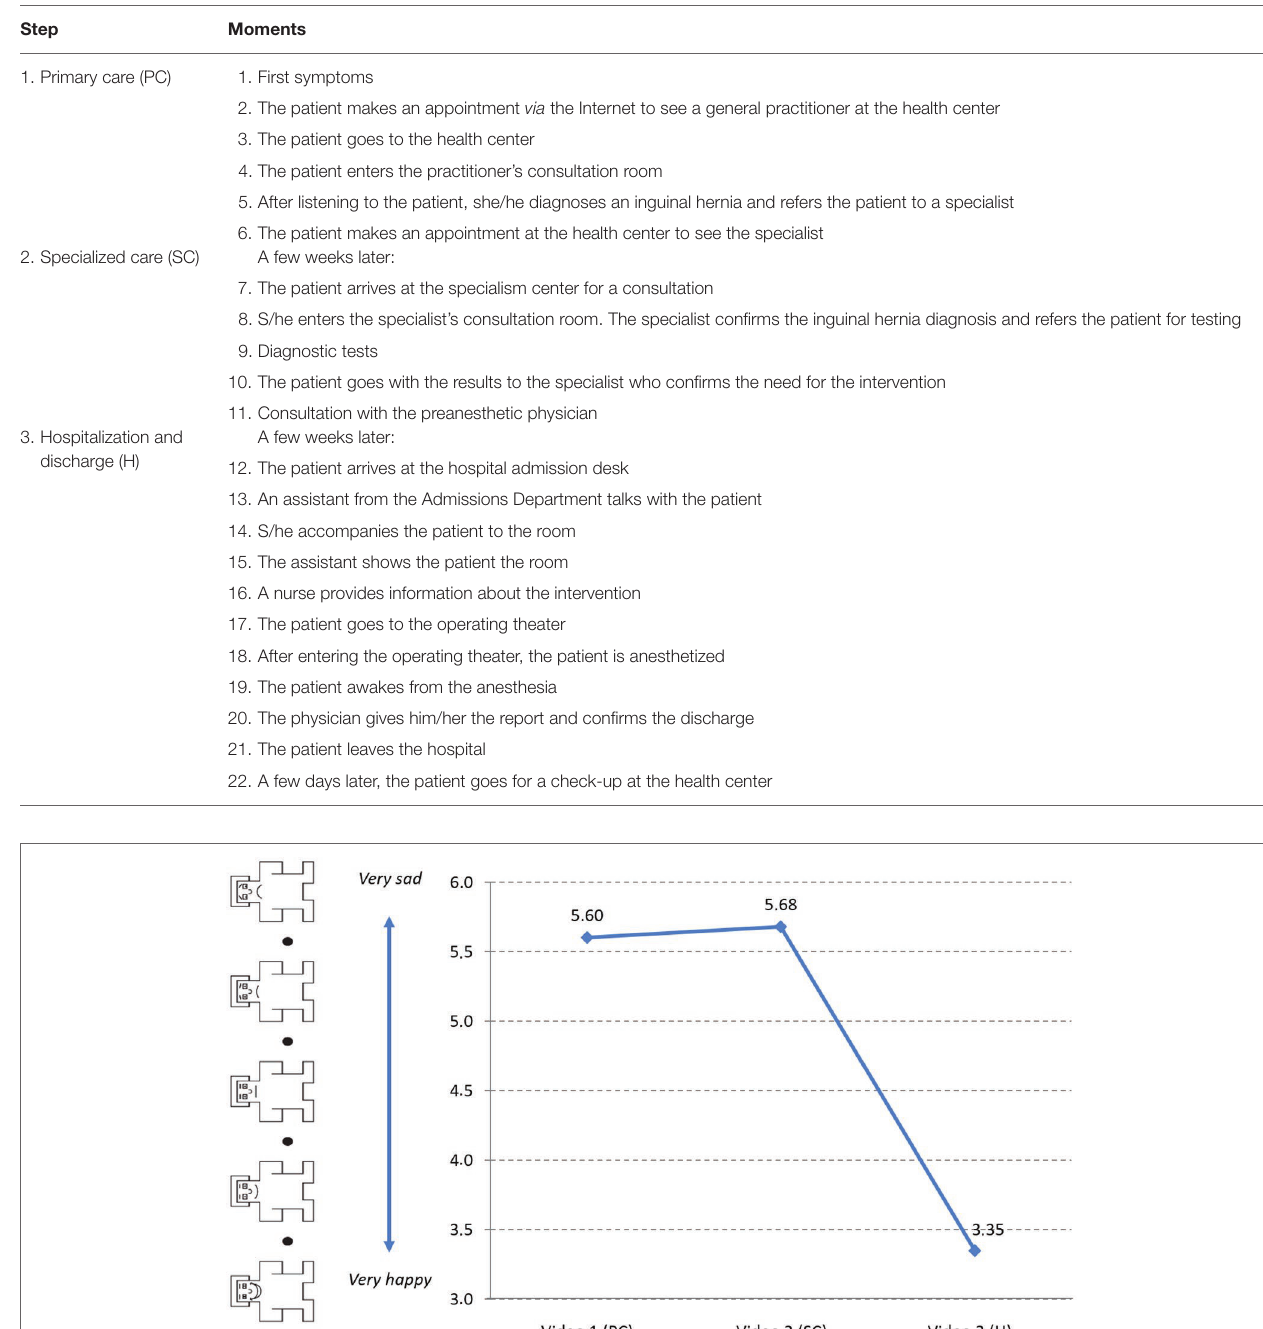
TABLE 1 | Patient journey, inguinal hernia repair